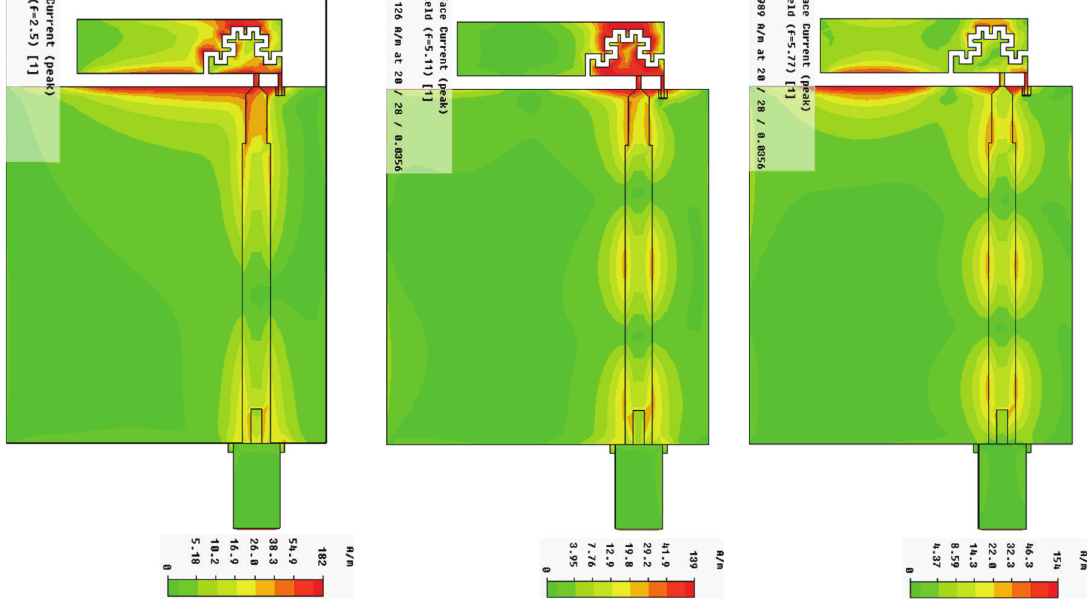
Figure 10: Surface current distributions of the dual-band D-GK2 PIFA at 2.5GHz, 5.11GHz, and 5.77